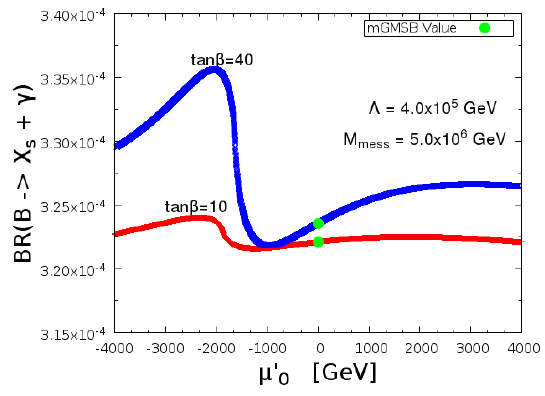
Figure 5 . The variation of Br ( B ! X s + (cid:13) ) with (cid:22) 0 The red and blue lines correspond to tan (cid:12) = 10 and 40 respectively. Green (cid:12)lled circles on the top of the lines specify the corresponding mGMSB values.